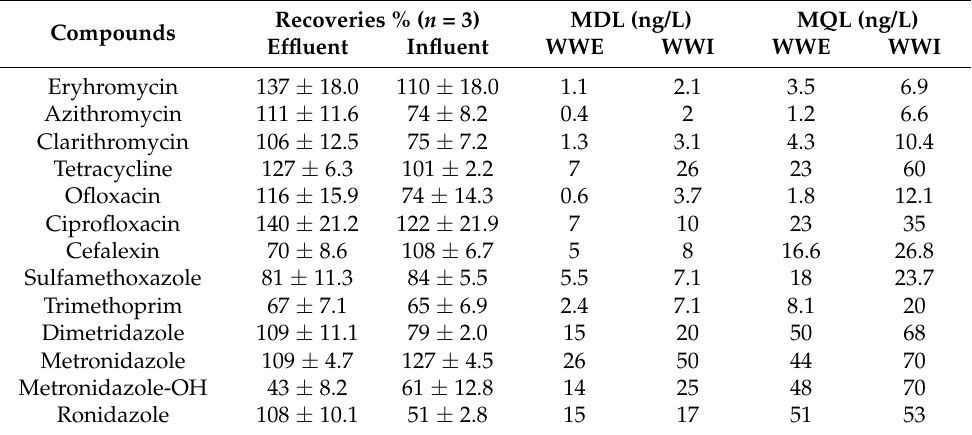
Table 2. Parameters indicating the performance of the analytical method: Method detection and quantification limits (MDL and